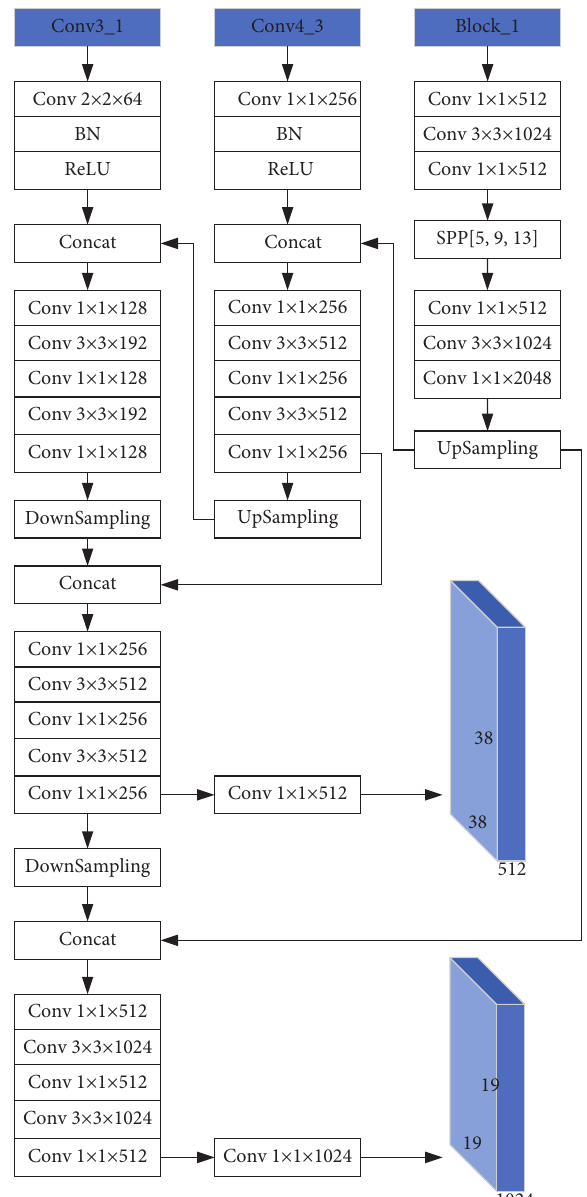
Figure 8: Structure of feature fusion network based on bidirectional FPN.